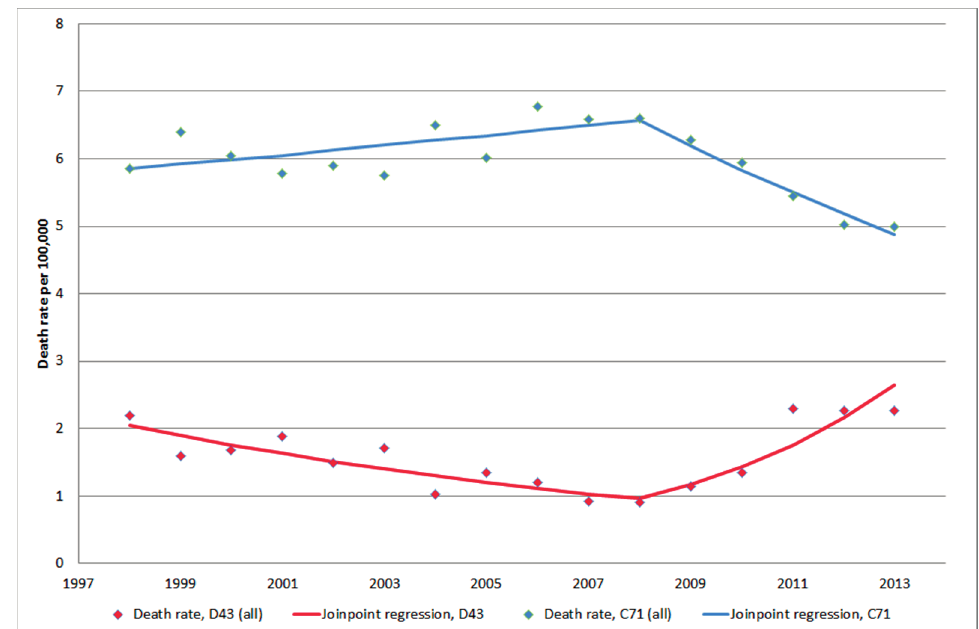
Figure 8. Joinpoint regression analysis of age-standardized death rates per 100,000 inhabitants according to the Swedish Causes of Death Register for both genders combined, all ages during 1998–2013 diagnosed with D43 = tumour of unknown type in the brain or CNS and C71 = malignant brain tumours [29].